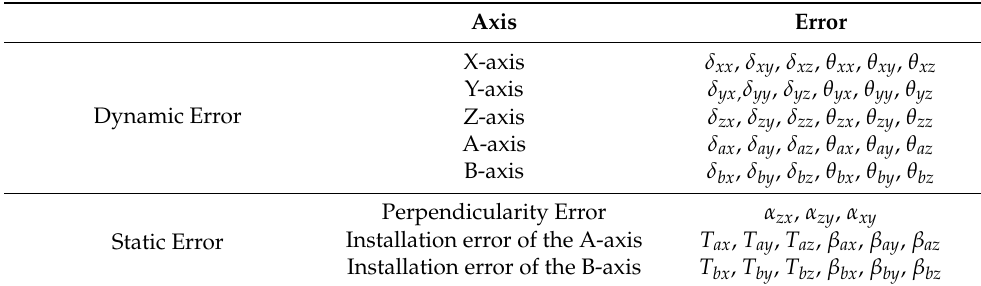
Figure 2. System model: ( a ) Structural model; ( b ) error model based on a multi-body mathematical model. Table 1. The error of the measurement